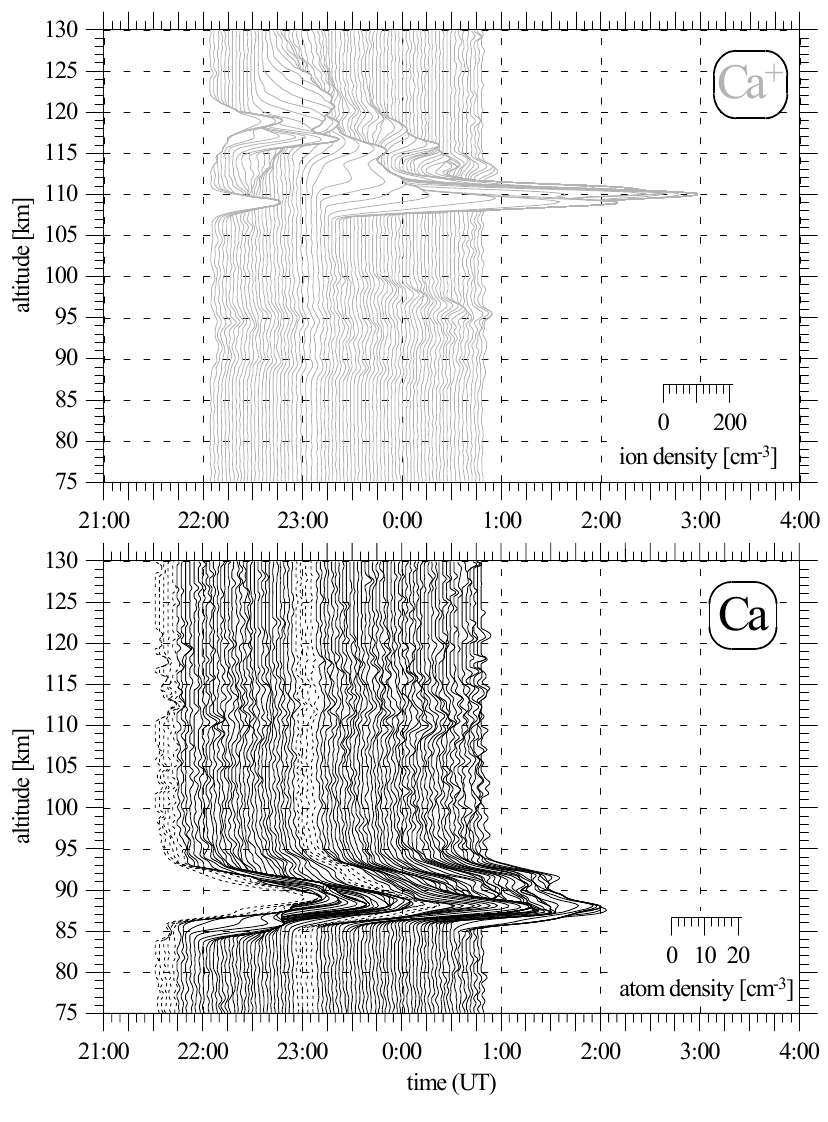
Fig. 6. Series of density profiles ob- tained during the night June 6/7, 1997 for Ca + (upper panel) and Ca (lower